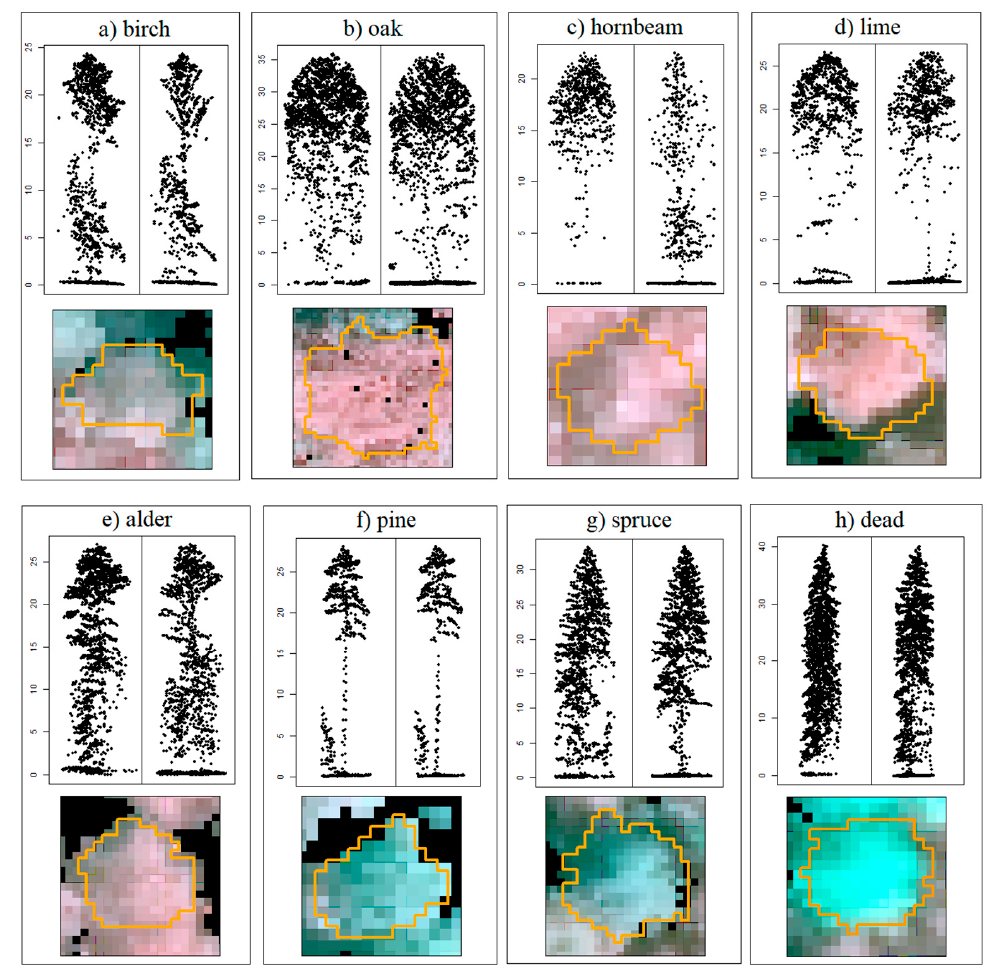
Figure 2. Presentation of examples of selected trees showing a properly segmented tree and its profile on the leaf-on (left) and leaf-off (right) point cloud. Table 2. Number (n) of selected reference trees divided into particular species. Additionally, information about the minimum (Min), maximum (Max), and mean (with standard deviation (SD)) height of trees in each class is presented.